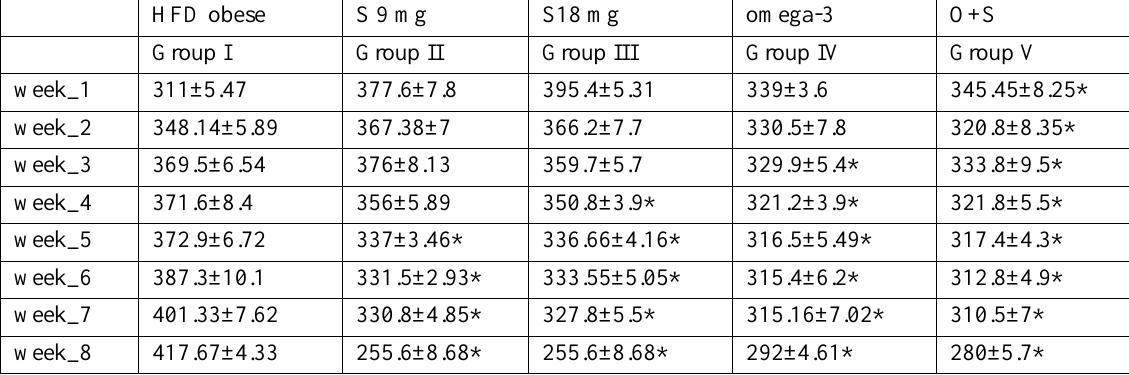
Table 3. Values of body weight of male Wistar rats through eight weeks reduction of body